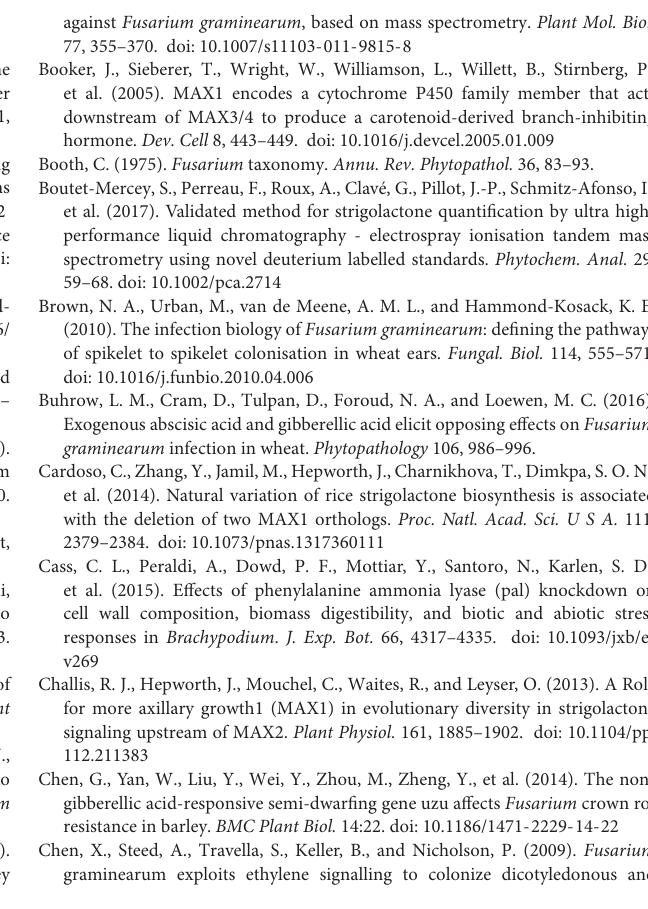
Supplementary Table 5 | Characteristics of the mutant families identified in the BdCYP711A29 gene following screening of the Bd21-3 TILLING collection (Dalmais et al., 2013). Supplementary Table 6 | Raw data and calculation of relative quantity of oranbanchol in exudates of WT (Bd21-3), overexpressing (OE-CYP12.20) and mutant (M5374#135) lines after 7 d phosphorus starvation. AUC: Area under the curve. MRM transitions 321 > 224 and 347 > 97 were used to quantify GR24 and orobanchol signals,